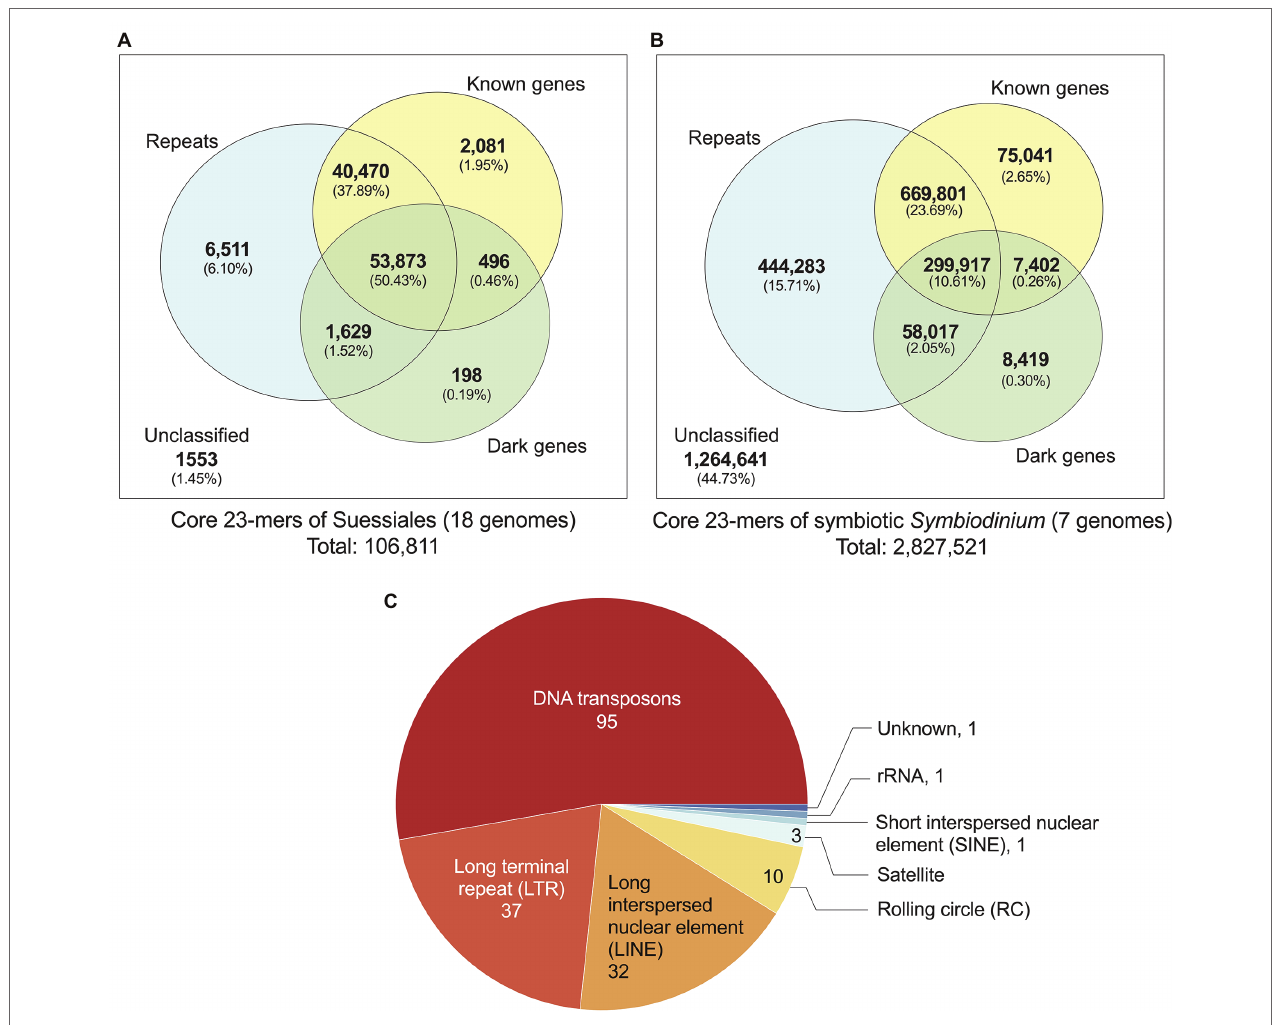
FIGURE 2 | Annotated genome features associated with core 23-mers identified for: (A) all 18 genomes of Suessiales, and (B) the seven genomes of symbiotic Symbiodinium . The Venn diagrams shown in (A) and (B) are not to scale. (C) Repeat classes identified as significantly more abundant and/or significantly more conserved in symbiotic Symbiodinium than in free-living members of this